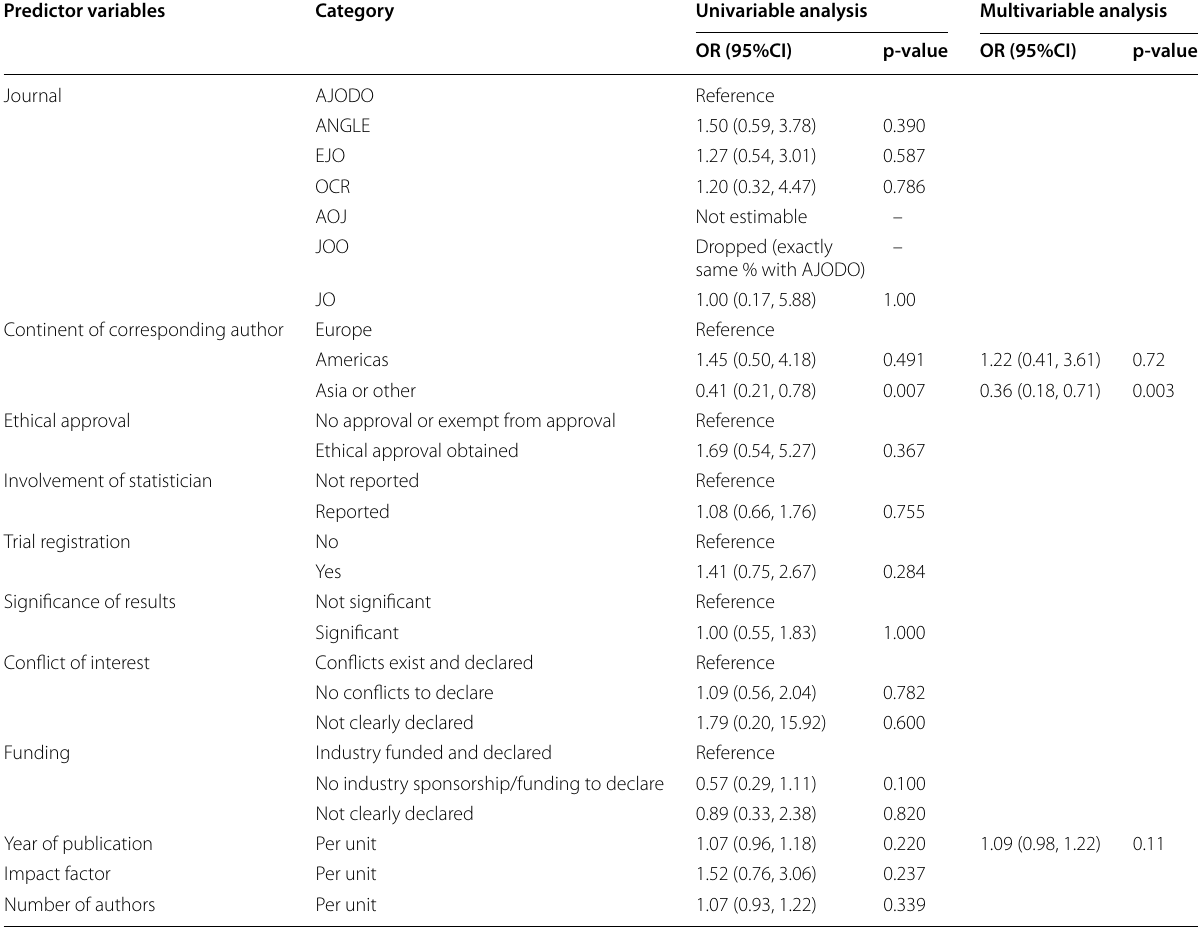
Table 3 Univariable and multivariable logistic regression derived odds ratios (OR) and 95% confidence intervals (CI) for the effect of year of publication, journal, continent of corresponding author, ethical approval, involvement of statistician, trial registration, significance of results, conflict of interest, funding, impact factor and number of authors on the likelihood of SR inclusion Predictor